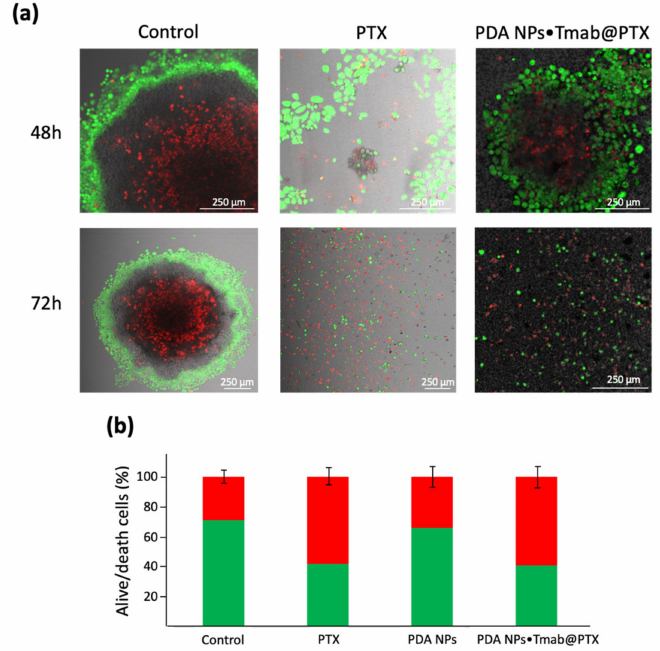
Figure 6. ( a ) CLSM images of BT474 MCTS 48 and 72 h after treatment with PTX (99.5 nM) and PDA NPs • Tmab@PTX (0.035 mg/mL). Cell viability and death were again assessed by using calcein AM (green) and propidium iodide (red); ( b ) percentage of living (green) and dead (red) BT474 cells cultured in 3D spheres, determined by cell-counting, 48 h after treatment with PTX (99.5 nM), PDA NPs (0.035 mg/mL) and PDA NPs • Tmab@PTX (0.035